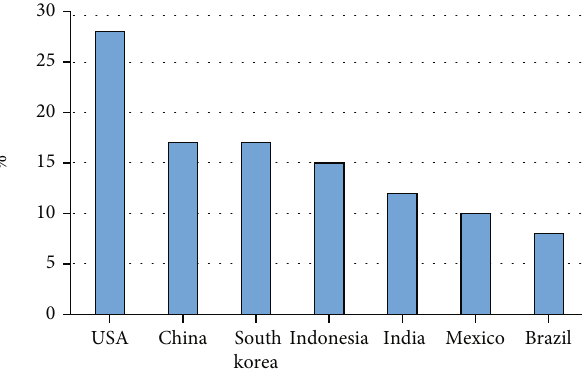
Figure 6: The share of cooling load from the peak of the electricity network in di ff erent